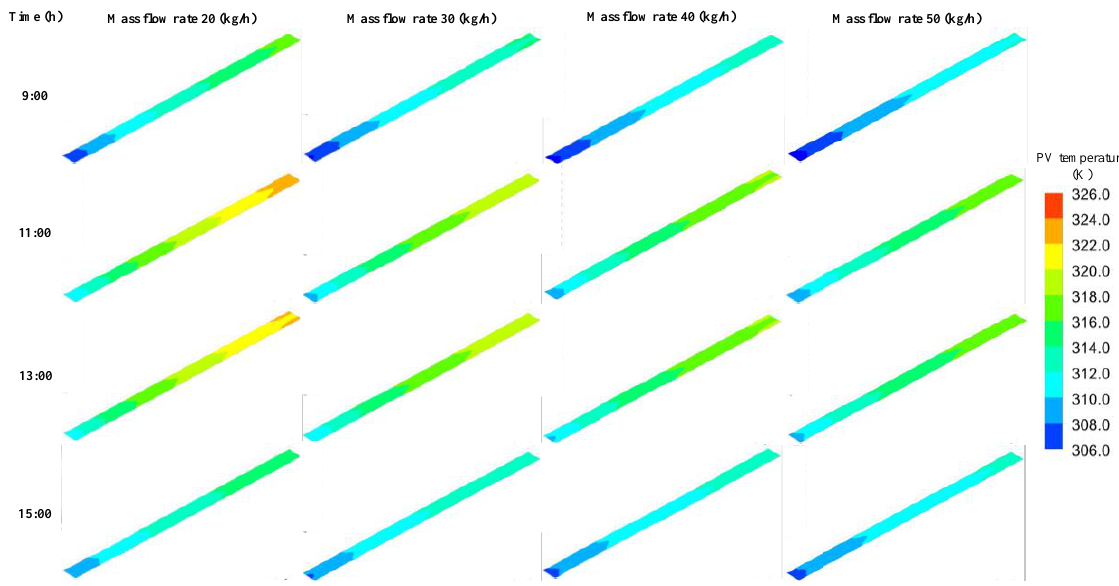
Fig. 7. Contours of PV surface temperature at different WF mass flow rates and time during a day in